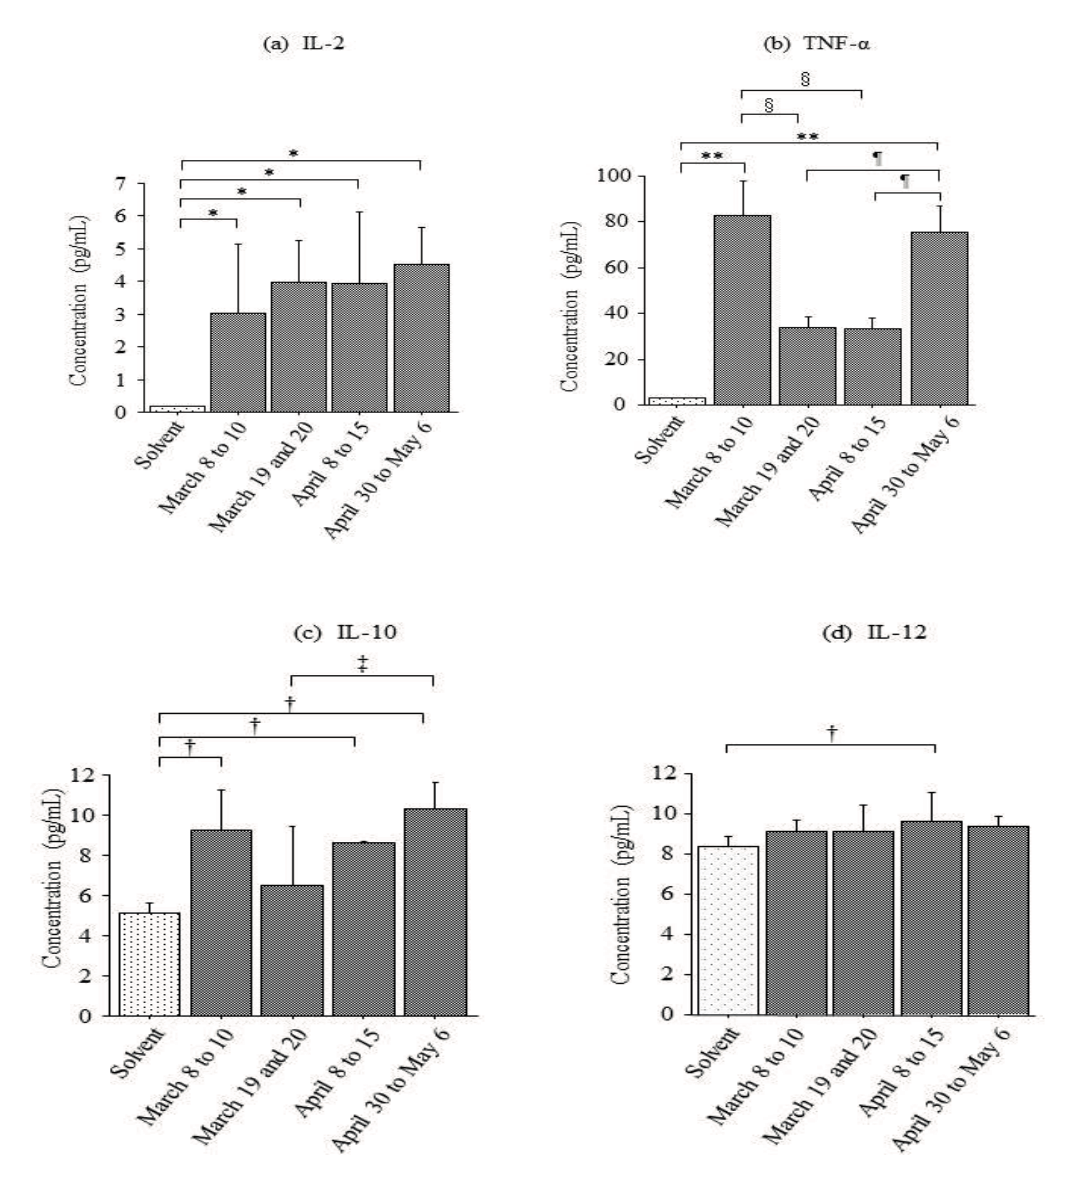
Figure 1. The levels of ( a ) interleukin (IL)-2; ( b ) tumor necrosis factor (TNF)- α ; ( c ) IL-10; and ( d ) IL-12 were measured in a THP1 cell line using a Bio-Plex Human Cytokine Th1/Th2 Assay. Particulate matter was collected in 2013 from 8 to 10 March, on 19 and 20 March, from 8 to 15 April, and from 30 April to 6 May. Particulate matter collected from 8 to 10 March and on March 19 and 20 was defined as Asian dust storm (ADS) particles, whereas matter collected from 8 to 15 April and from 30 April to 6 May represented non- ADS particles. Cells were treated with solvent only ( n = 4, negative control) and particulate matter (all n = 4; 200 μ g/mL). * p < 0.05 vs. solvent, ** p < 0.0005 vs . solvent, † p < 0.05 vs. solvent, § p < 0.01 vs. particulate matter collected from 8 to 10 March, p < 0.05 vs. particulate matter collected from 30 April to 6 May, ‡ p < 0.03 vs. particulate matter collected from 30 April to 6